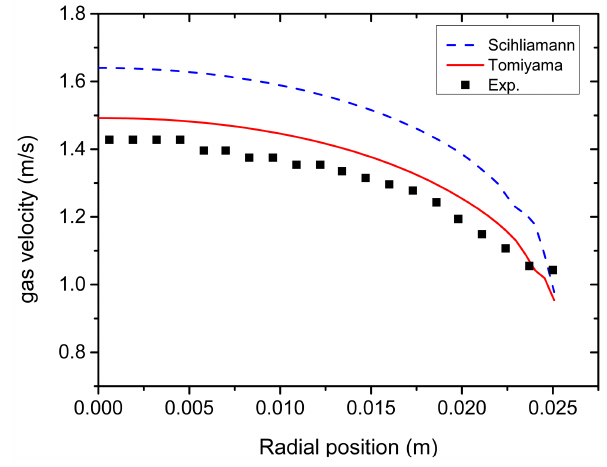
Figure 7. Gas phase velocity calculated by different drag forces.